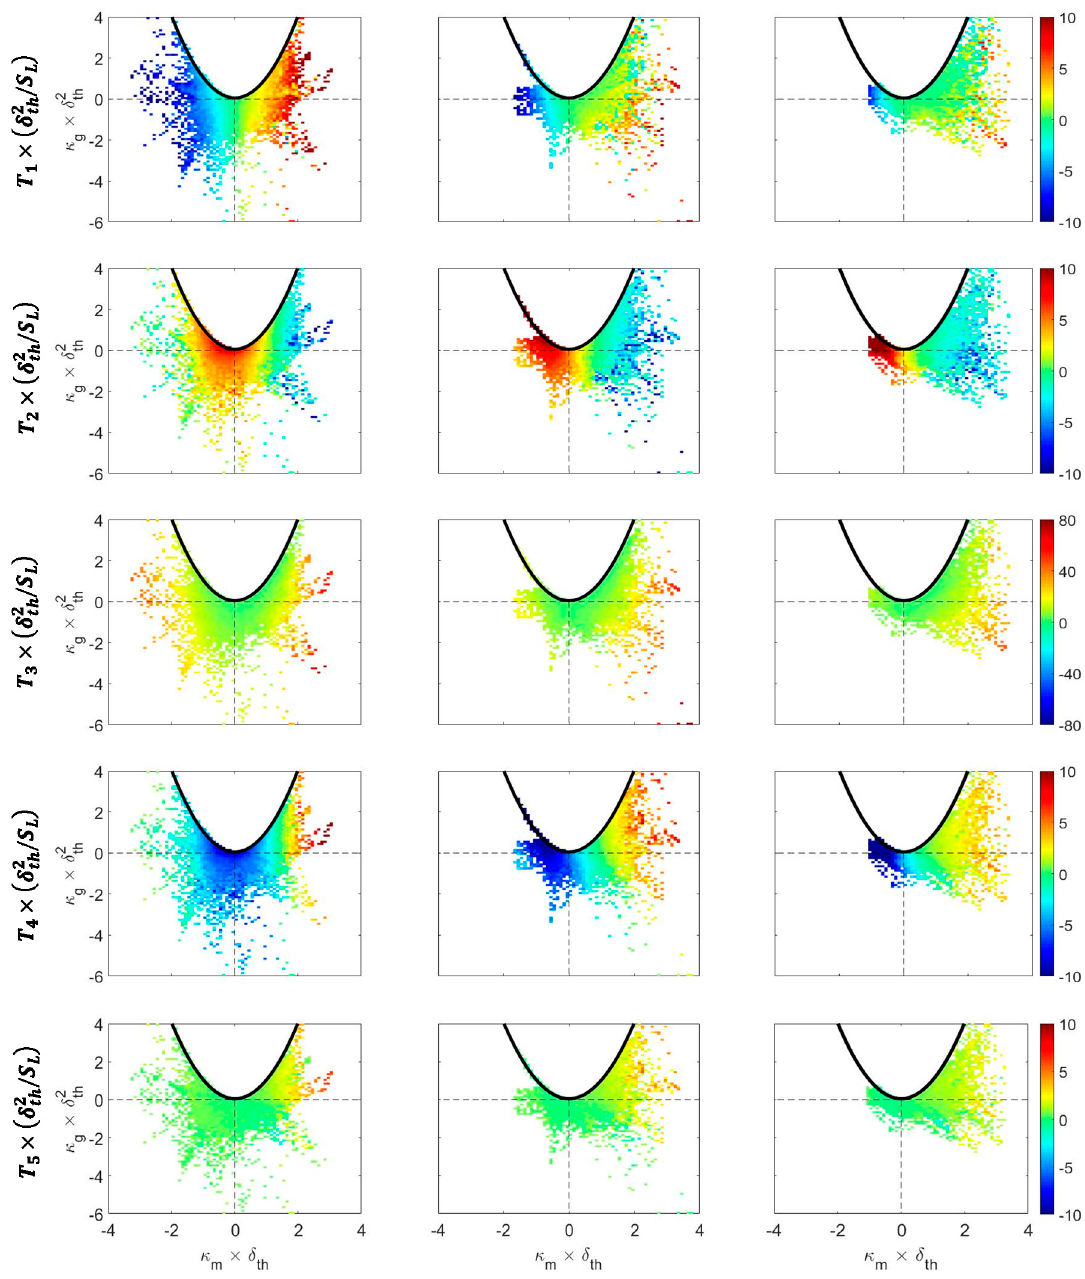
Figure 7. Variations of the mean values of T 1 − 5 × ( δ 2 / S L ) (1st–5th row) conditional on κ m × δ th and κ g × δ 2 for Le = 0.8, 1.0 and 1.2 flames (1st–3rd column) for c = 0.8 isosurface.